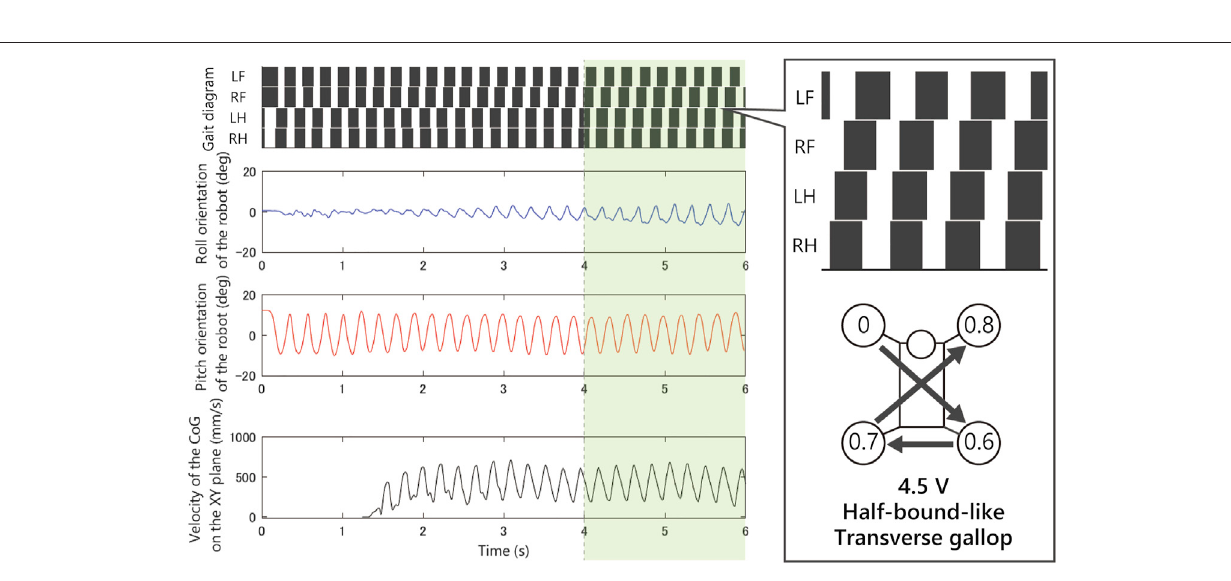
Frontiers in Robotics and AI |